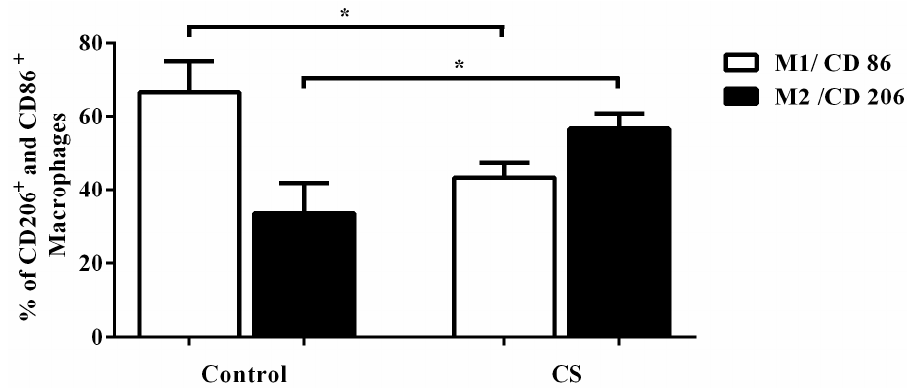
Figure 5. Effects of CS on the expression of CD86 (M1 marker) and CD206 (M2 marker) in bronchoalveolar lavage (BAL). The mice were exposed to 14 days of CS or air, and the percentage of CD86- and CD206-positive cells in BAL was determined by flow cytometry. All statistical analyses were performed with a one-way ANOVA, followed by a Tukey’s post hoc test. The data represent the means ± SEM of 7–10 mice per group. * p < 0.05 compared to control.